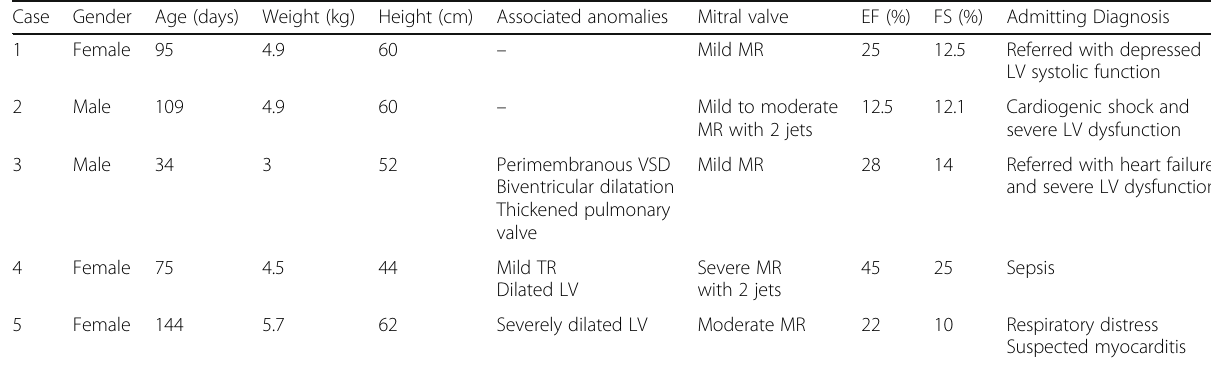
Table 1 Preoperative patients ’ characteristic Case Gender Age (days) Weight (kg) Height (cm) Associated anomalies